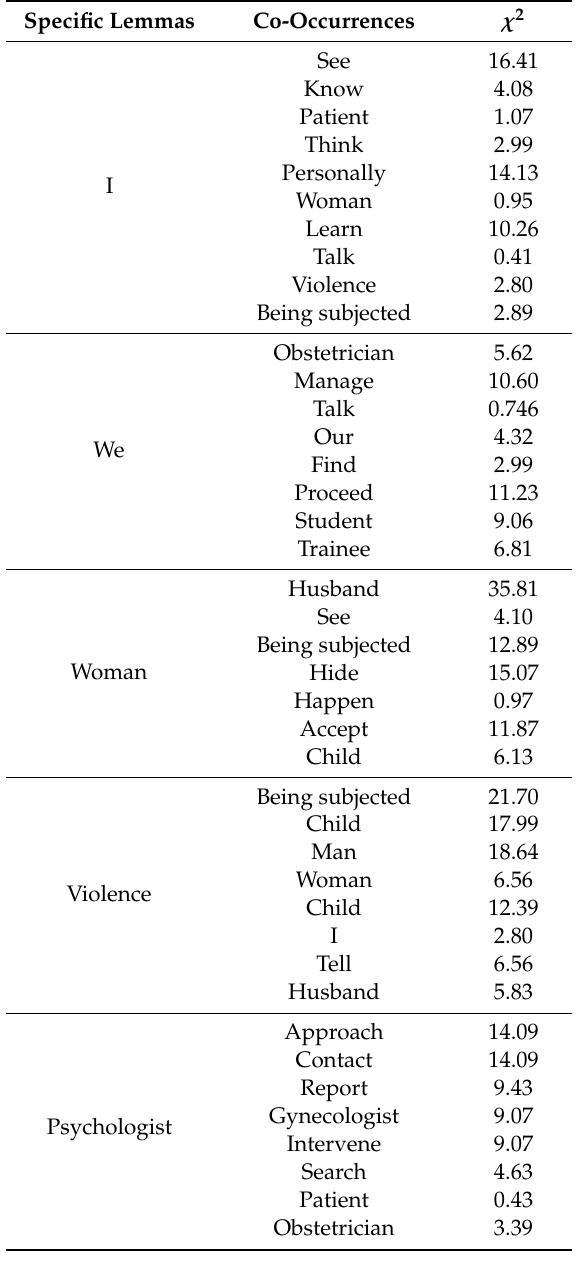
Table 2. Chi-square values ( χ 2 ) for the co-occurrences of the lemmas I, We, woman, violence, and